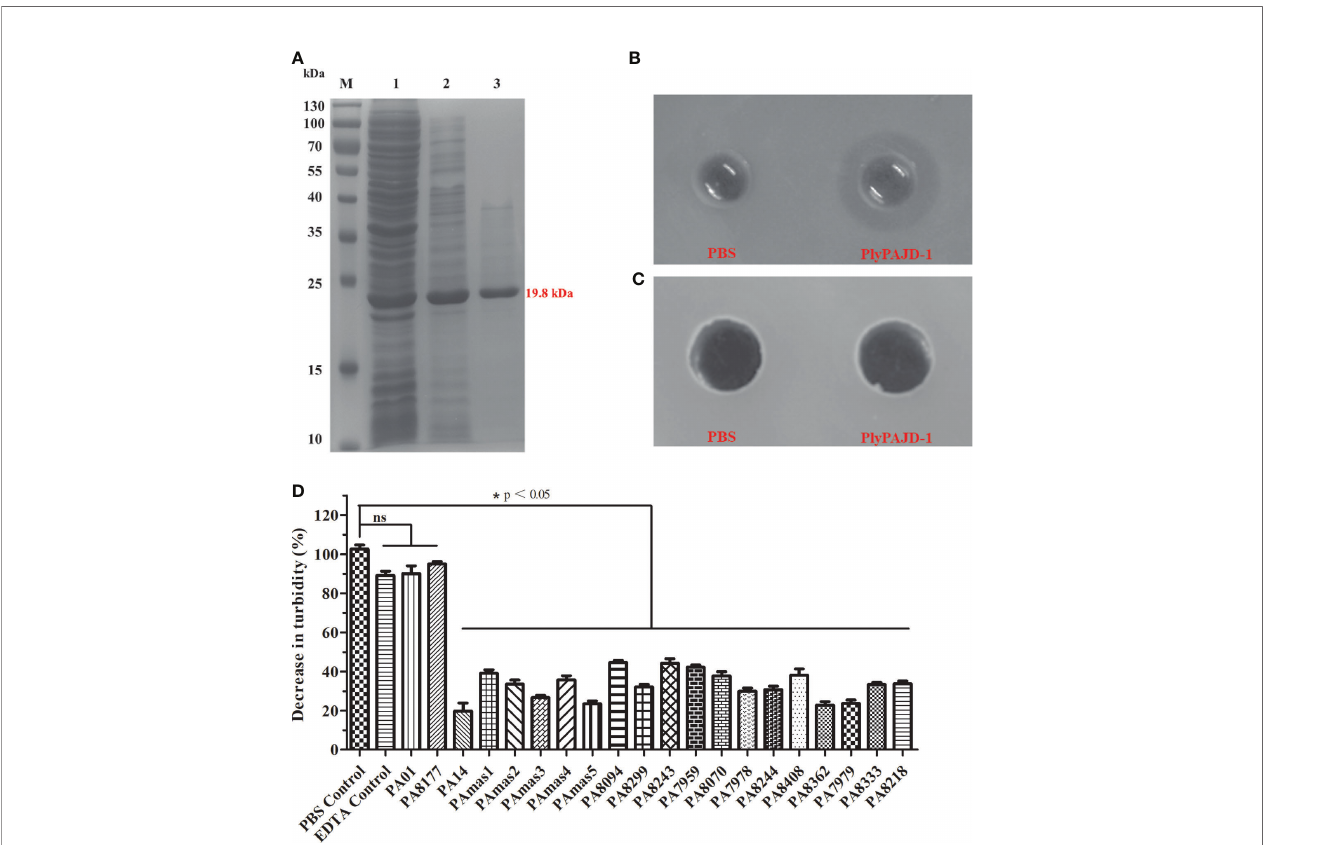
FIGURE 8 | The expression and lytic activity of PlyPAJD-1. (A) Sodium dodecyl sulphate – polyacrylamide gel electrophoresis (SDS-PAGE) analysis of PlyPAJD-1. M, molecular size marker; Lane 1, unpuri fi ed protein; Lane 2, fl ow-through sample; Lane 3, puri fi ed PlyPAJD-1 (19.8 kDa); (B, C) show the inhibition zone around the punched hole where the PlyPAJD-1 and PBS in bacteria pre-treated (B) with EDTA or (C) without EDTA, respectively. (D) The lytic spectrum of PlyPAJD-1 against different P. aeruginosa. Results are shown as means ± SEM from triplicate experiments. Signi fi cant differences ( p < 0.05) are indicated by asterisks and ns represents no signi fi